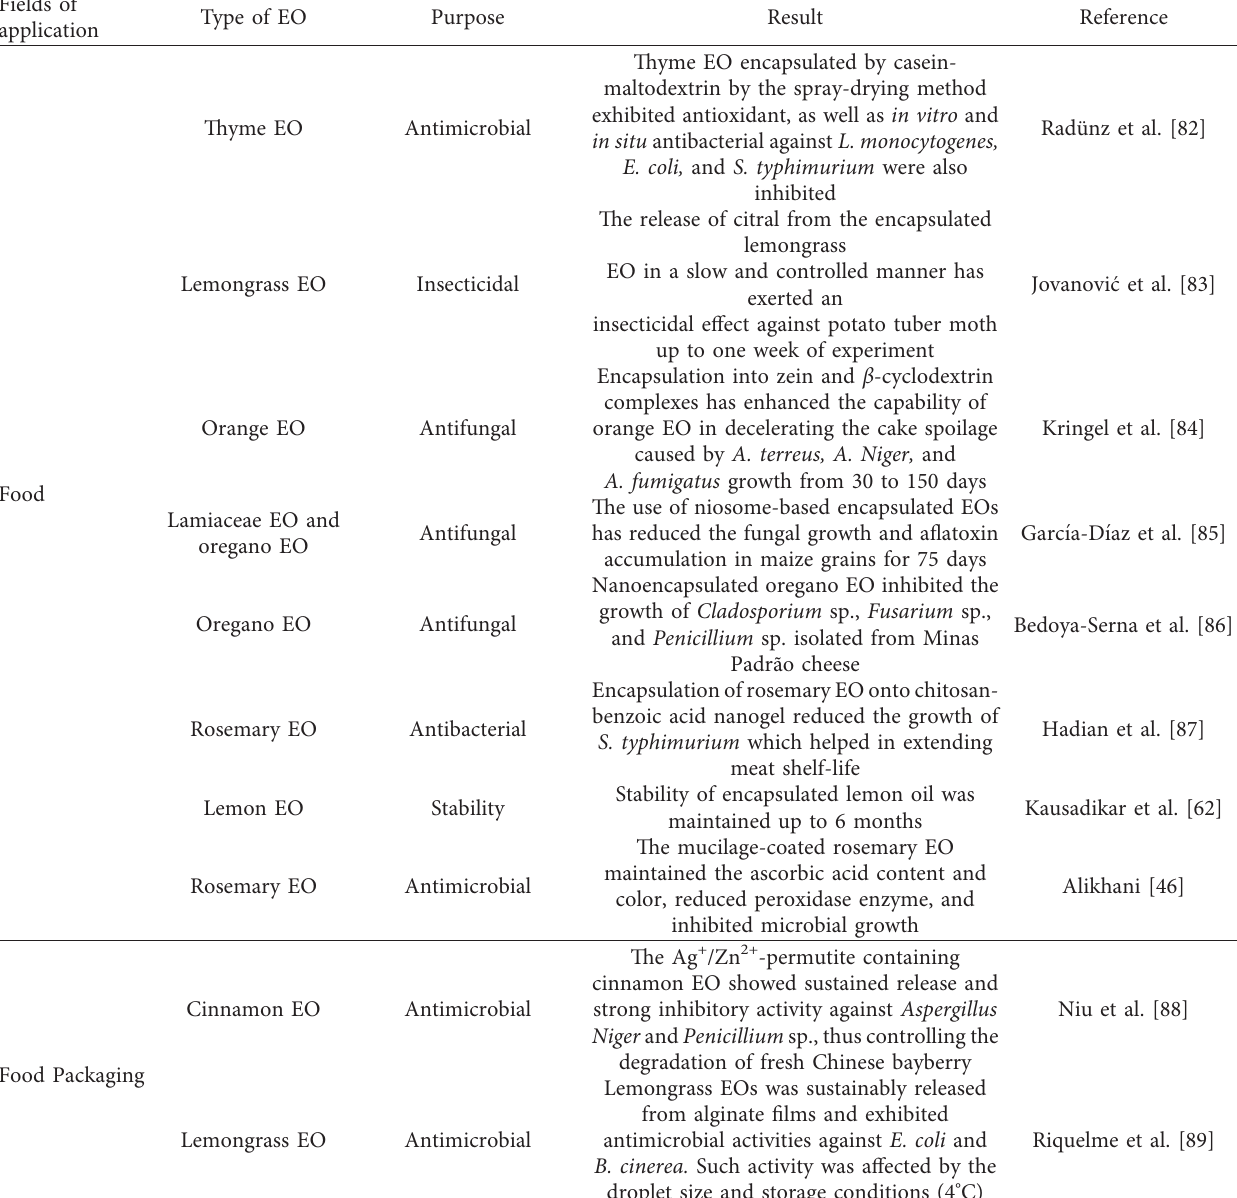
Table 2: Microencapsulated EOs applied in various